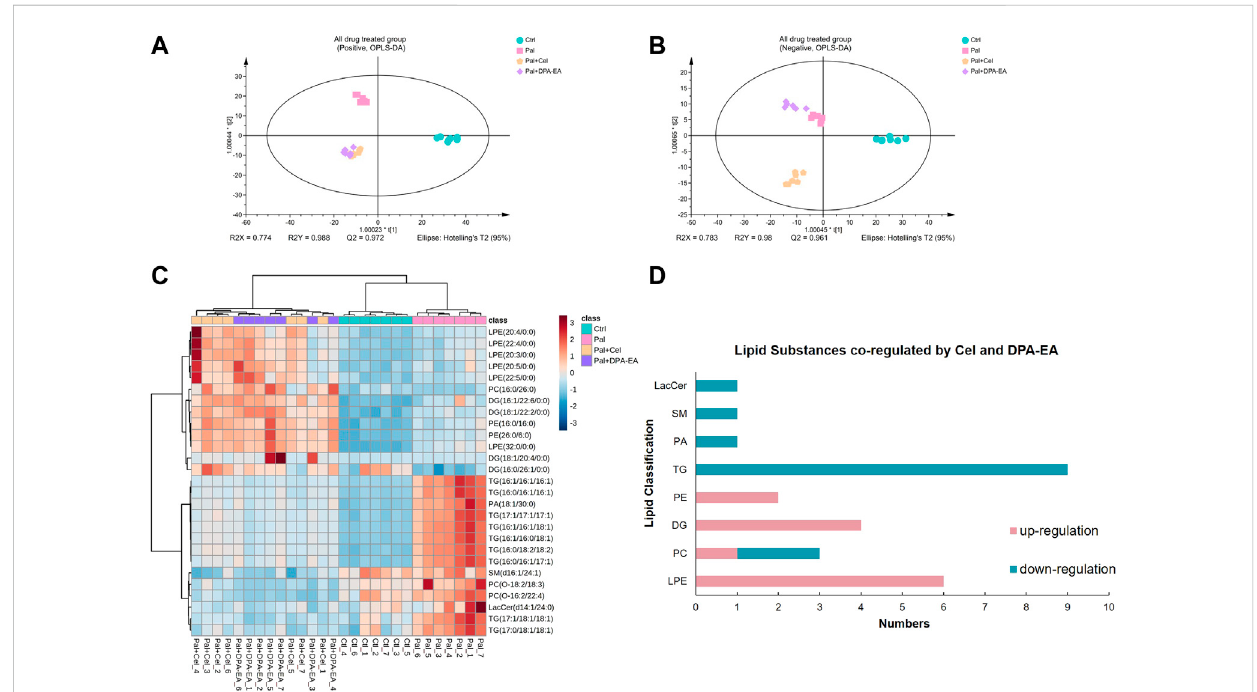
FIGURE 5 Analysis of signi fi cantly differential lipids in Ctrl, Pal, Pal + Cel, and Pal + DPA-EA groups. OPLS-DA score plots (A,B) in positive and negative ion modes, respectively. (C) Heatmap of common DELs in the Pal + Cel vs. Pal and Pal + DPA-EA vs. Pal models, selected with the fold change cutoff of FC > 1.5 or FC < 0.5 as upregulated and downregulated, respectively. Red and blue indicate increased and decreased lipids, respectively. (D) Classi fi cations of the regulated lipid